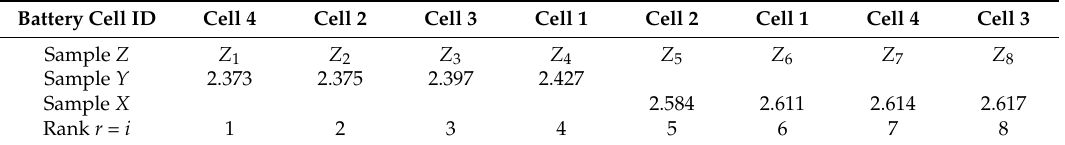
Table 5. The rank of